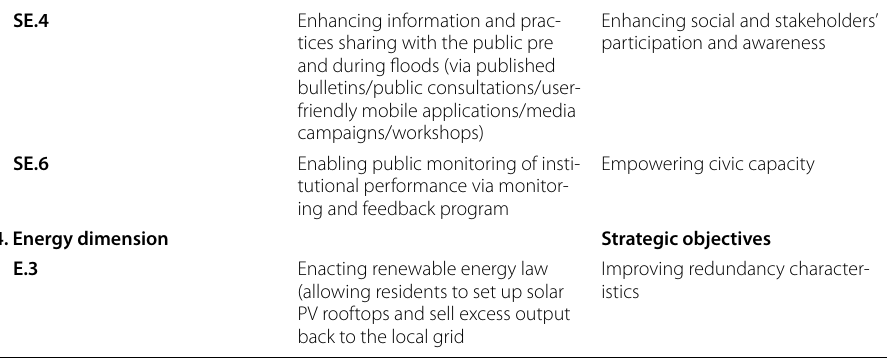
Table 8 Correlation matrix Resilience dimension